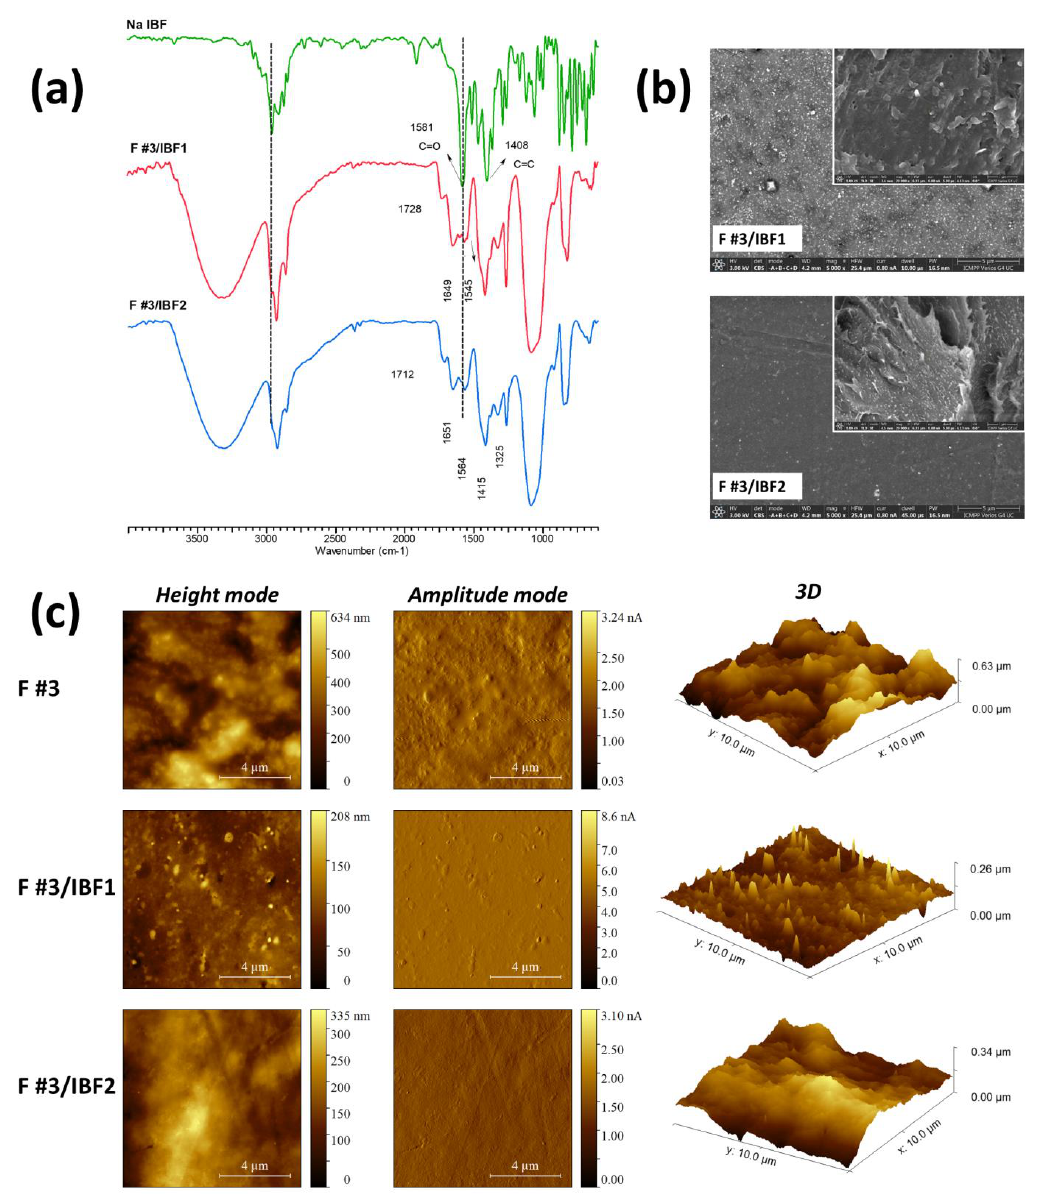
Figure 8. FTIR/ATR spectra ( a ), surface and cross-section morphology obtained by SEM analysis ( b ), and surface AFM images ( c ) of the unloaded and ibuprofen-loaded PVA/OxCS-Ag films.